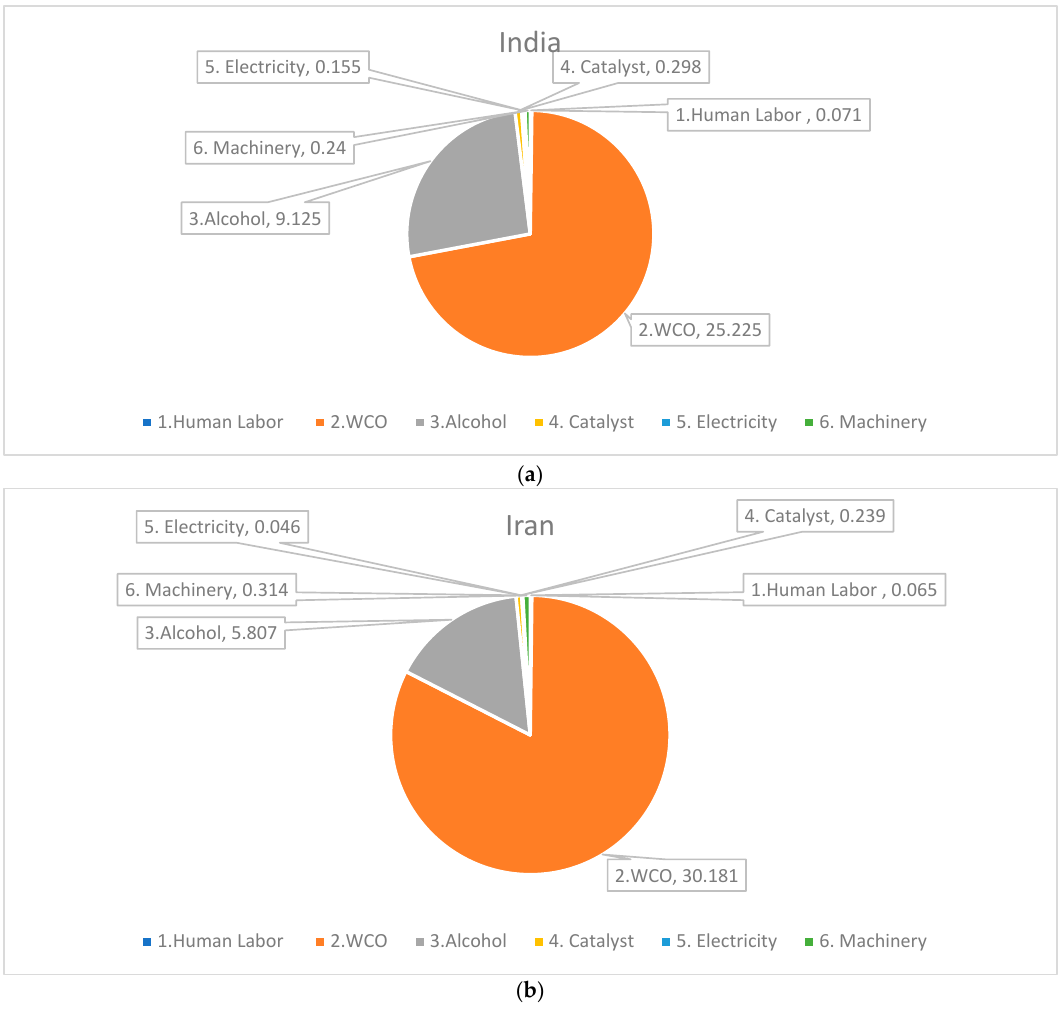
Figure 7. Input energy details for biodiesel production—( a ) India and ( b ) Iran.